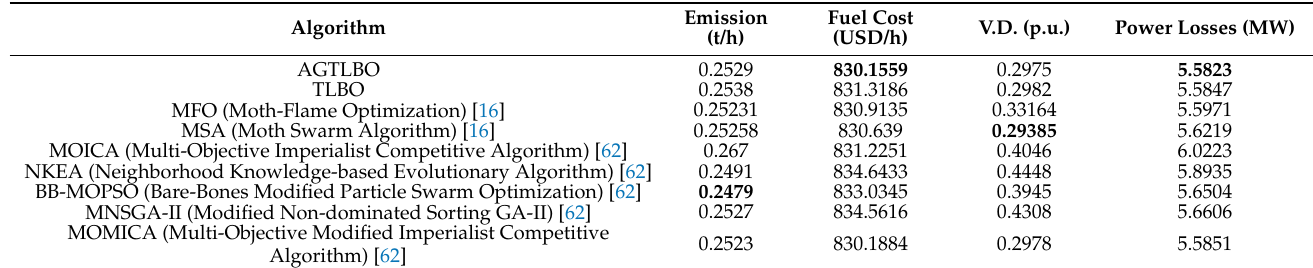
Table 9. Optimal results by different algorithms for Case 8.